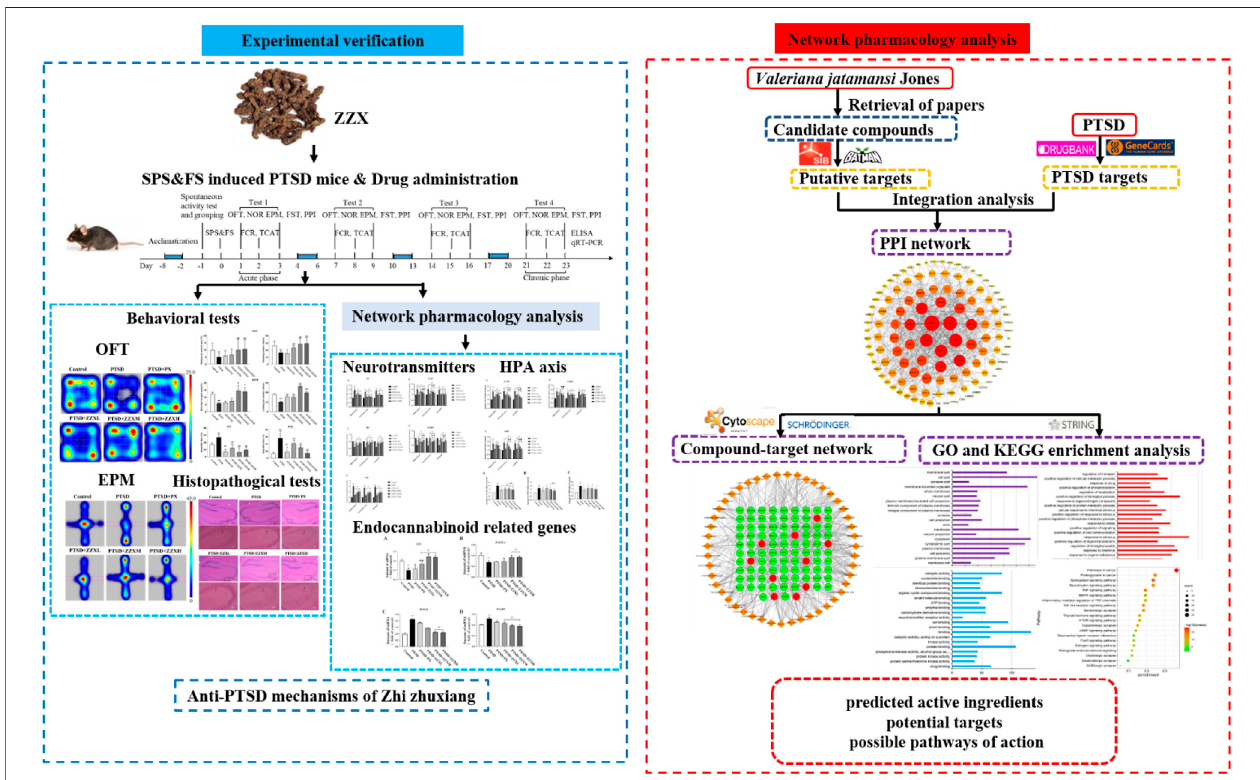
FIGURE 1 | Schematic diagram of the